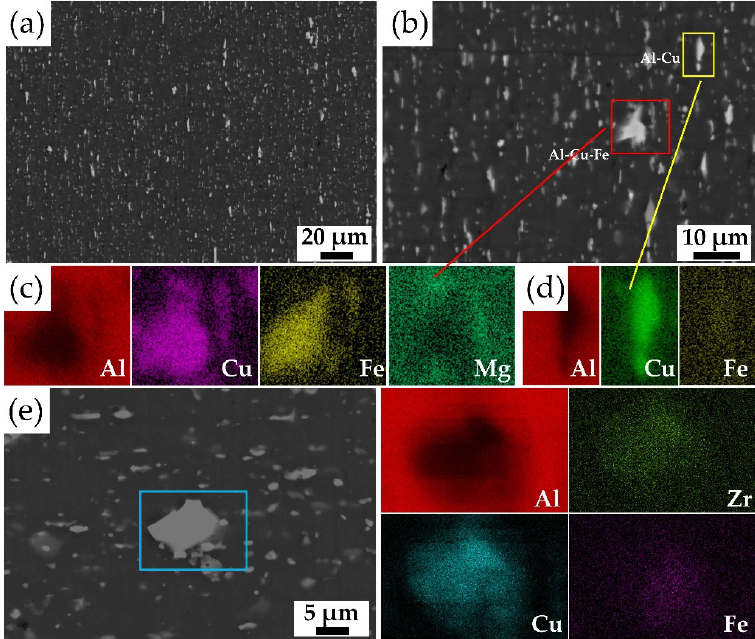
Figure 4. ( a ) SEM image of the extruded alloy for the P2; ( b , e ) SEM images of the extruded alloy with partial enlargement; ( c , d ) the corresponding EDS scan composition mappings.